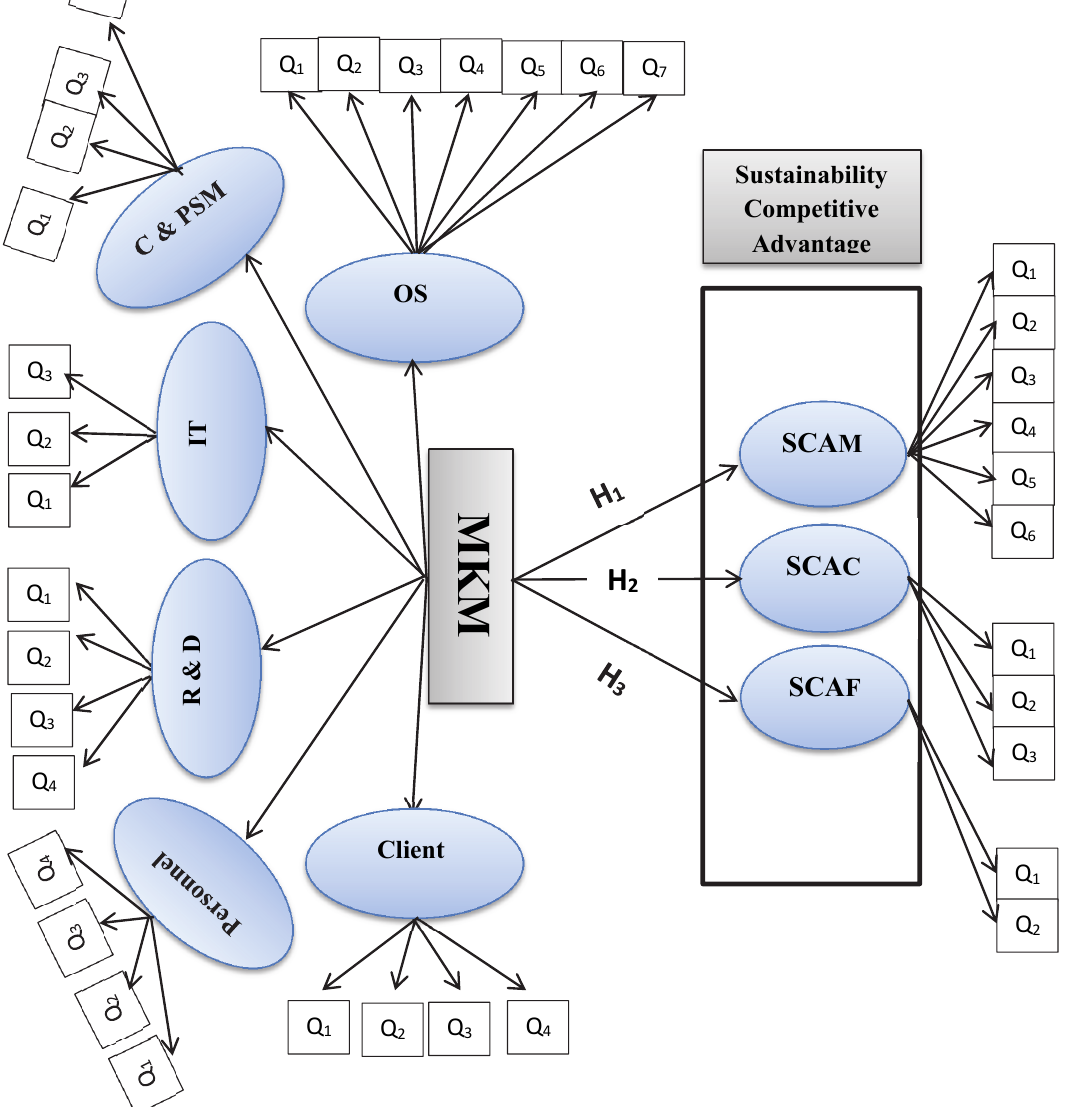
Fig. 1. Conceptual model between MKM and